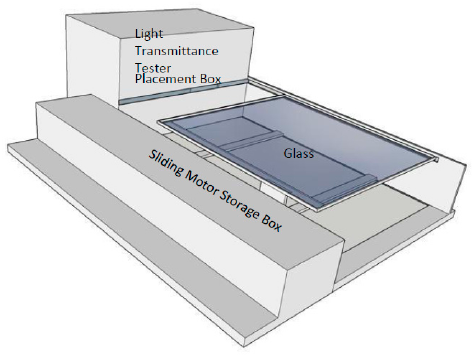
Figure 9. Design of the automatic dust measurement platform.